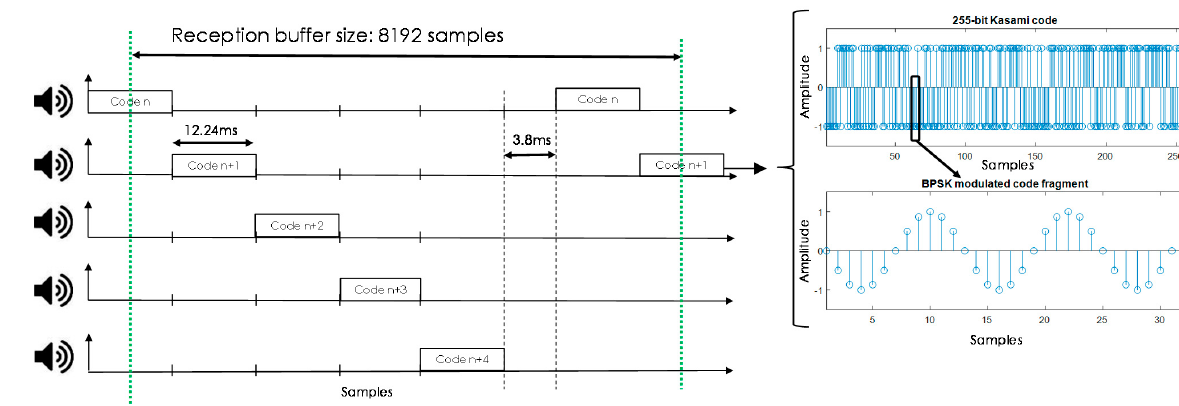
Figure 4. Modulation scheme and medium access technique applied to the beacon transmissions.